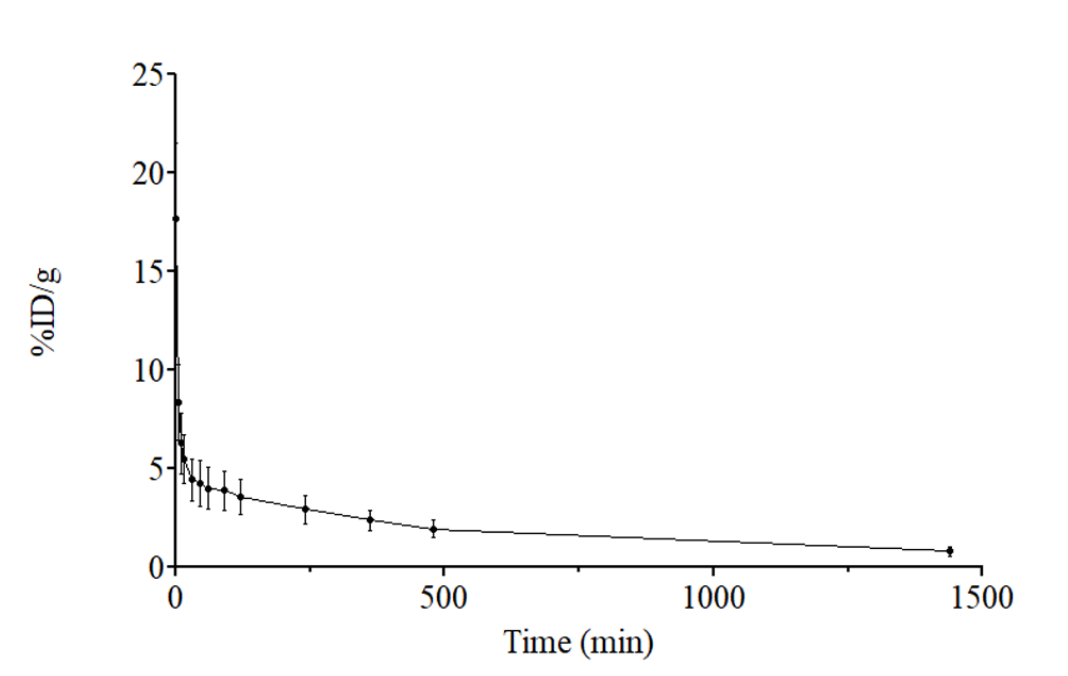
FIGURE 4 - Blood clearance of 99m Tc-CDV in healthy female SWISS mice. All data are the mean percentage (n=7) of the injected dose of 99m Tc-CDV per gram of blood, ±SD of the mean.